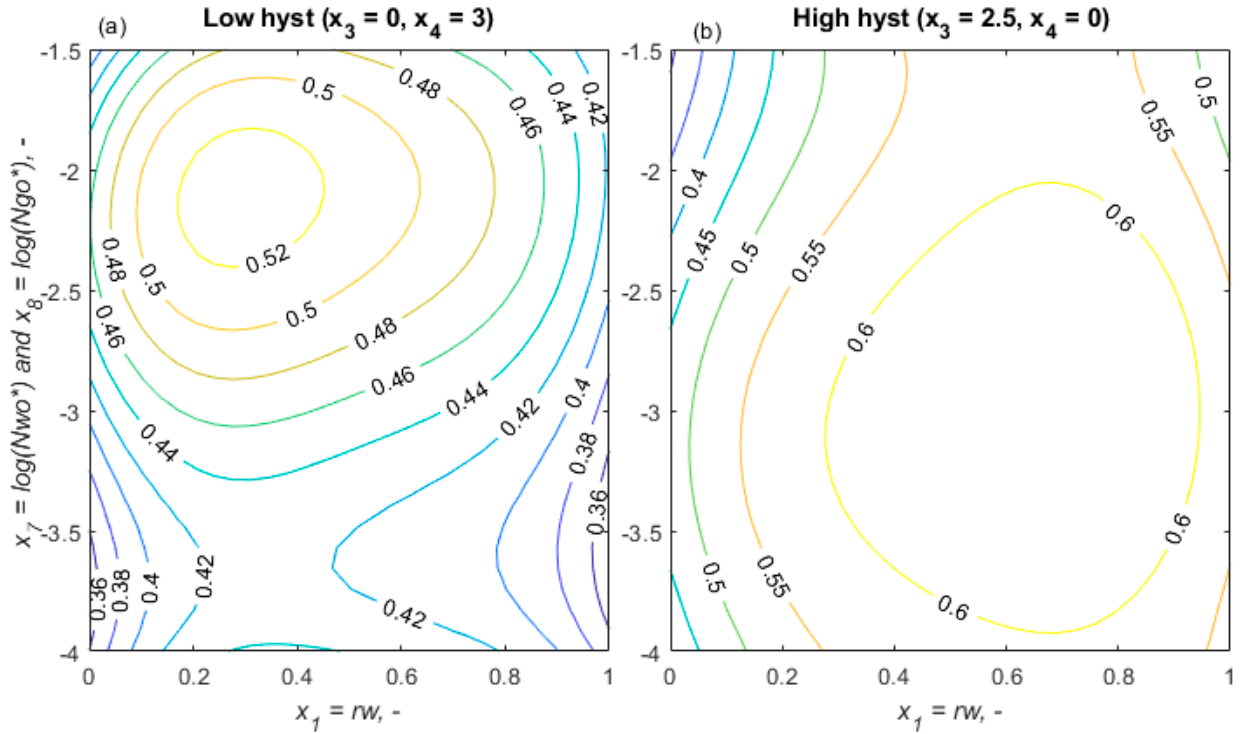
Figure 12. Contour plot of recovery factor RF plotted against 𝑥 (cid:2869) (cid:3404) 𝑟 (cid:3050) and log gravity number with equal values of 𝑥 (cid:2875) and 𝑥 (cid:2876) . Favorable ( a ) and unfavorable ( b ) mobility ratio cases are shown (see all input values in Table 6).